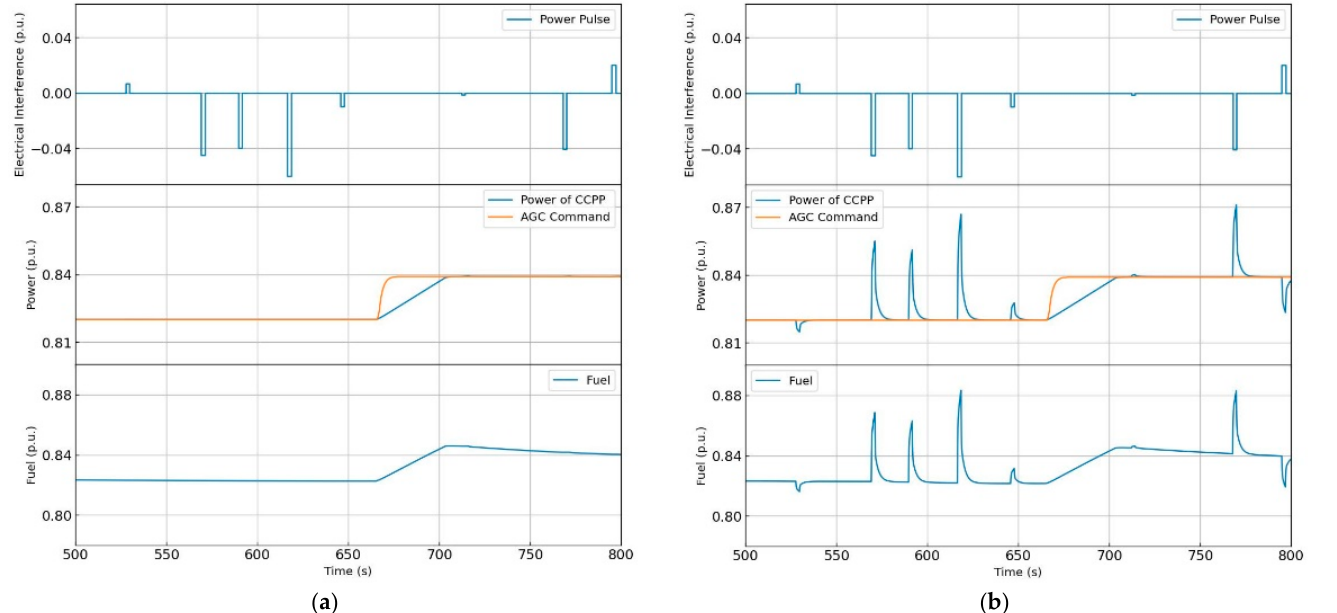
Figure 11. Simulation with different control methods. ( a ) Simulation with fault diagnosis isolation method. ( b ) Simulation without fault diagnosis isolation